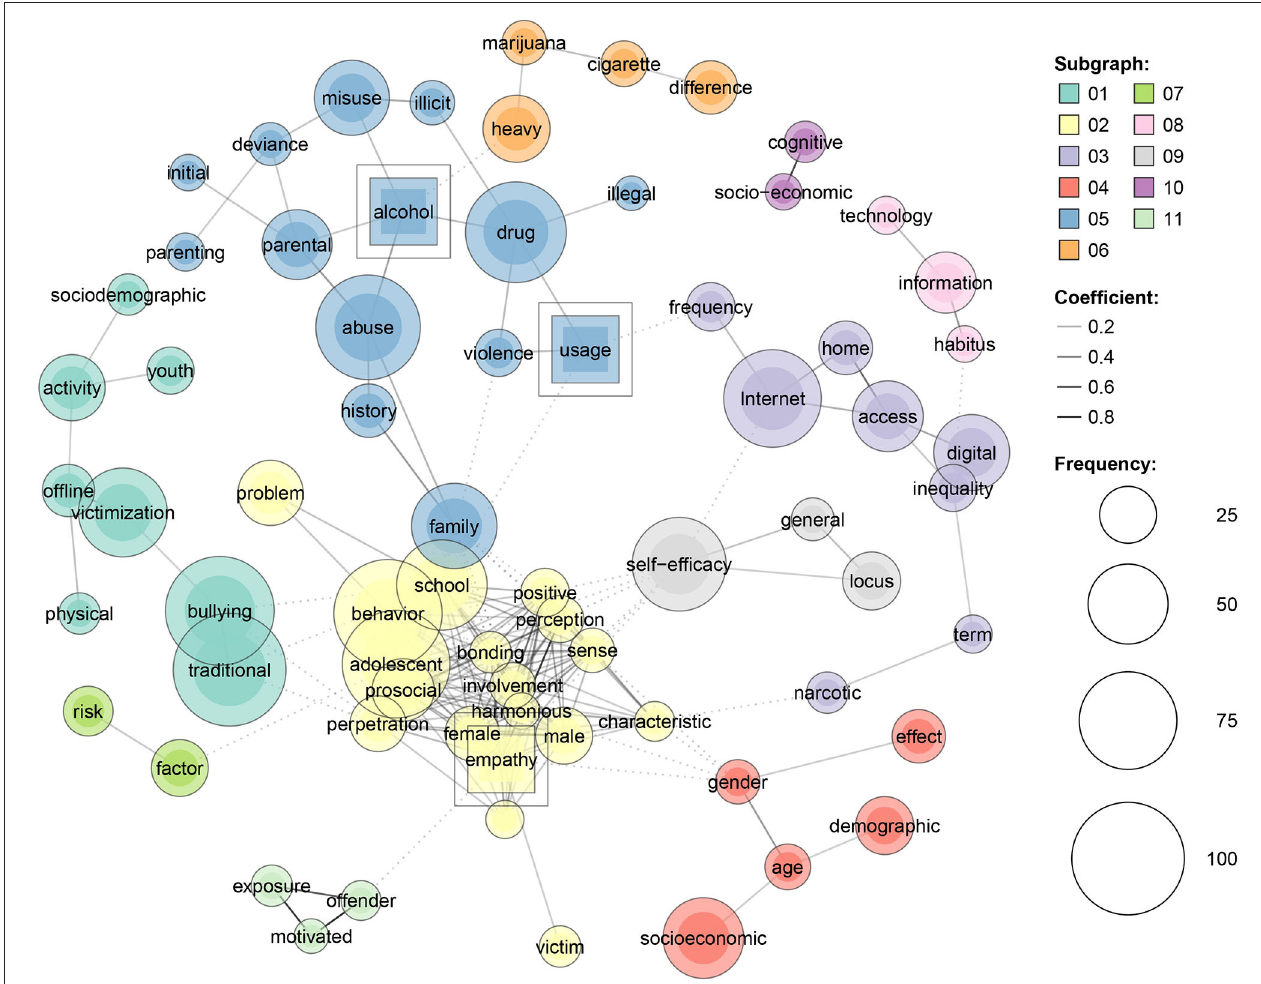
FIGURE 9 | Predictors of cyber deviance grounded on modularity